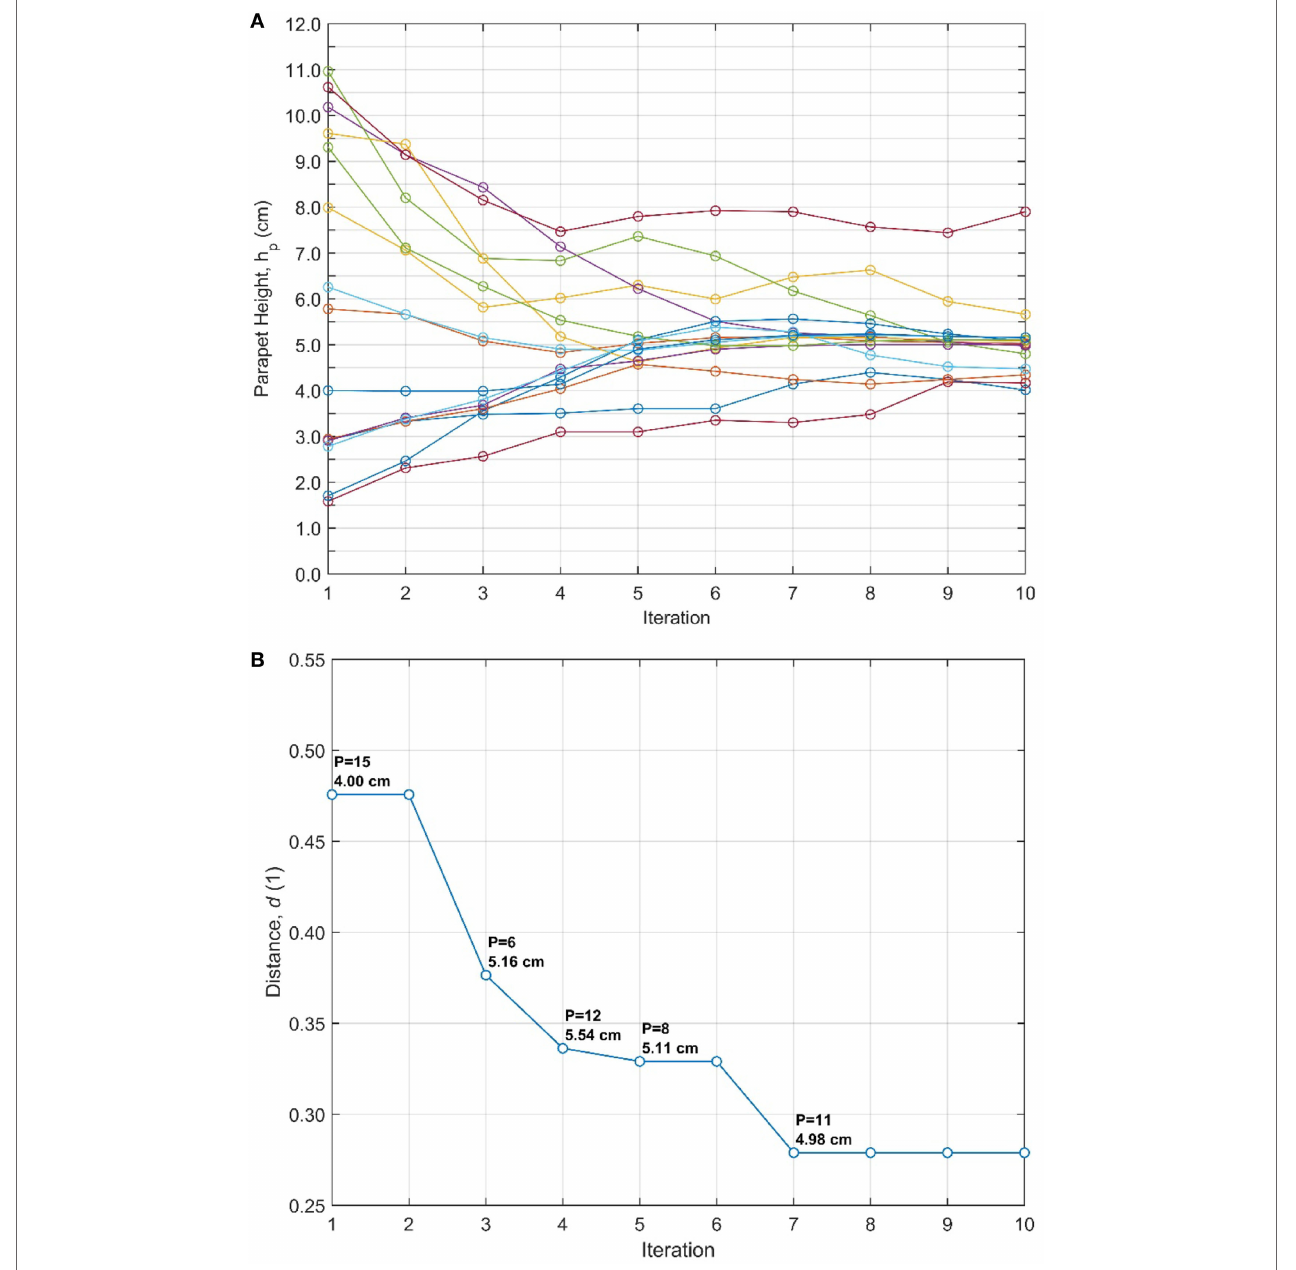
FIGURE 12 | (A) Particle convergence at each iteration and (B) iteration history of global best cost.